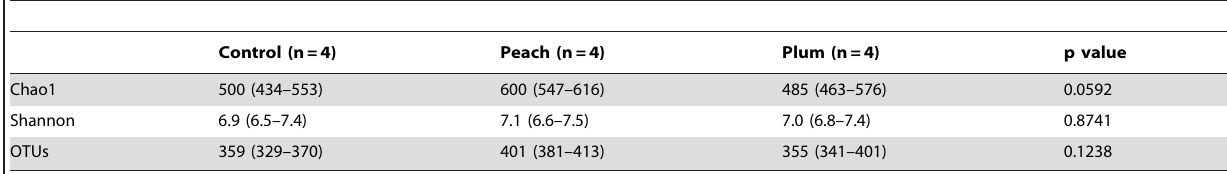
Table 2. Median (minimum-maximum) indices of bacterial diversity (Shannon Weaver and Chao1 3%) and richness (OTUs 3%) obtained from fecal samples of the control, peach and plum groups. P values come from the non-parametric Kruskal-Wallis.